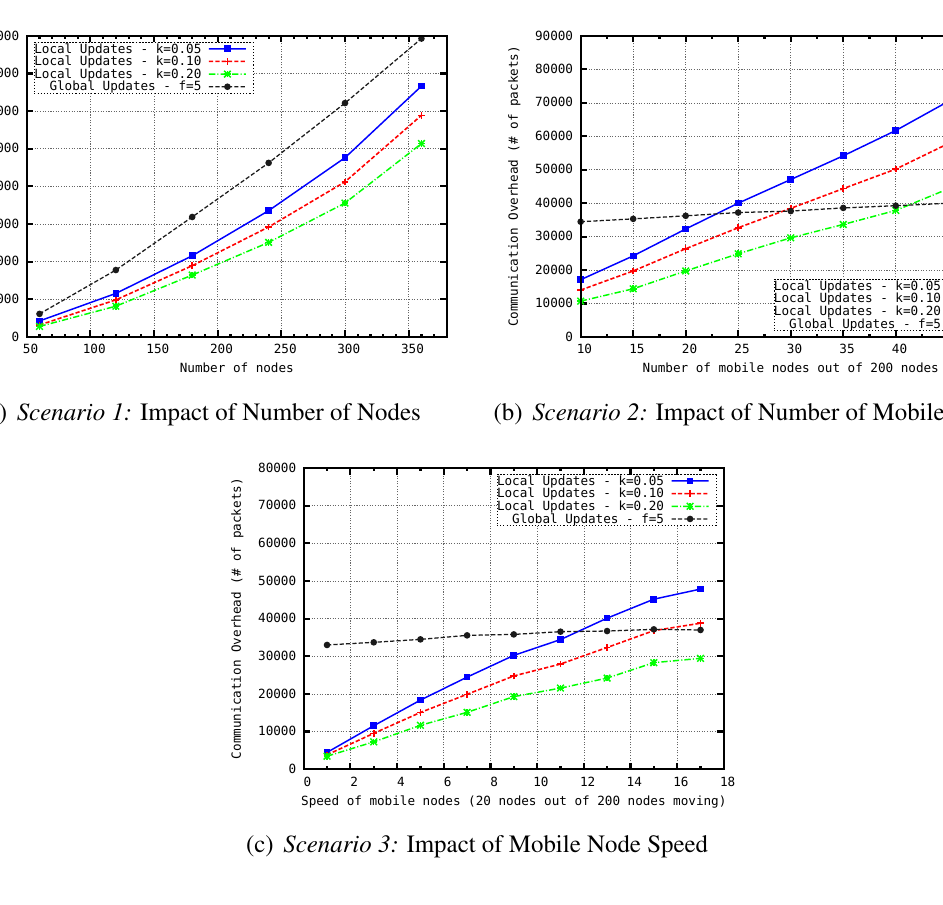
Figure 14. Comparison of local and global updates in terms of Communication